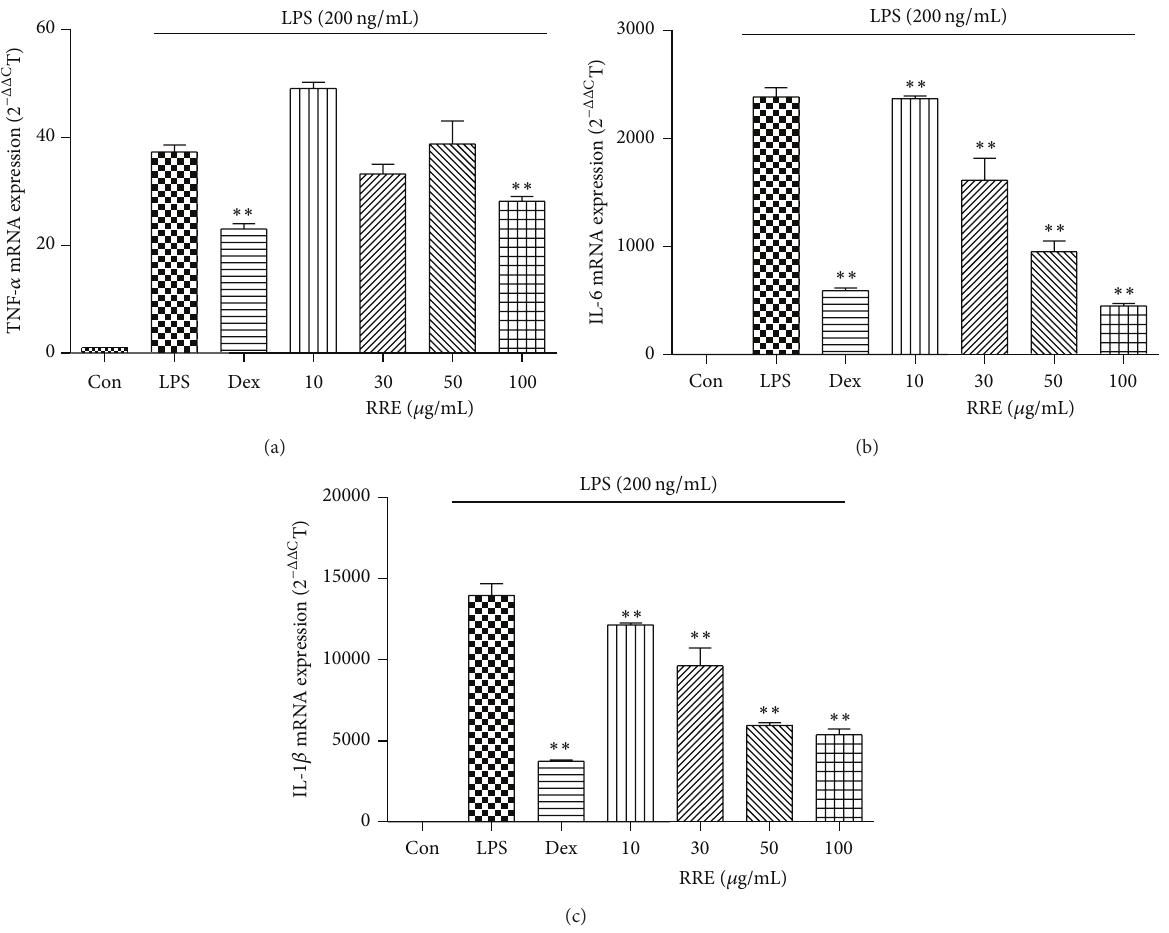
Figure 2: Effects of RRE treatment on LPS-induced (a) TNF- 𝛼 , (b) IL-6, and (c) IL-1 𝛽 mRNA expression in RAW 264.7 cells. Cells were pretreated with RRE for 1 h and stimulated with LPS for an additional 6 h. mRNA levels were measured by real-time RT-PCR. Data represent the mean ± SD of duplicate determinations from three independent experiments. ∗∗ 𝑝 < 0.001 was calculated from comparing with LPS- stimulation value.